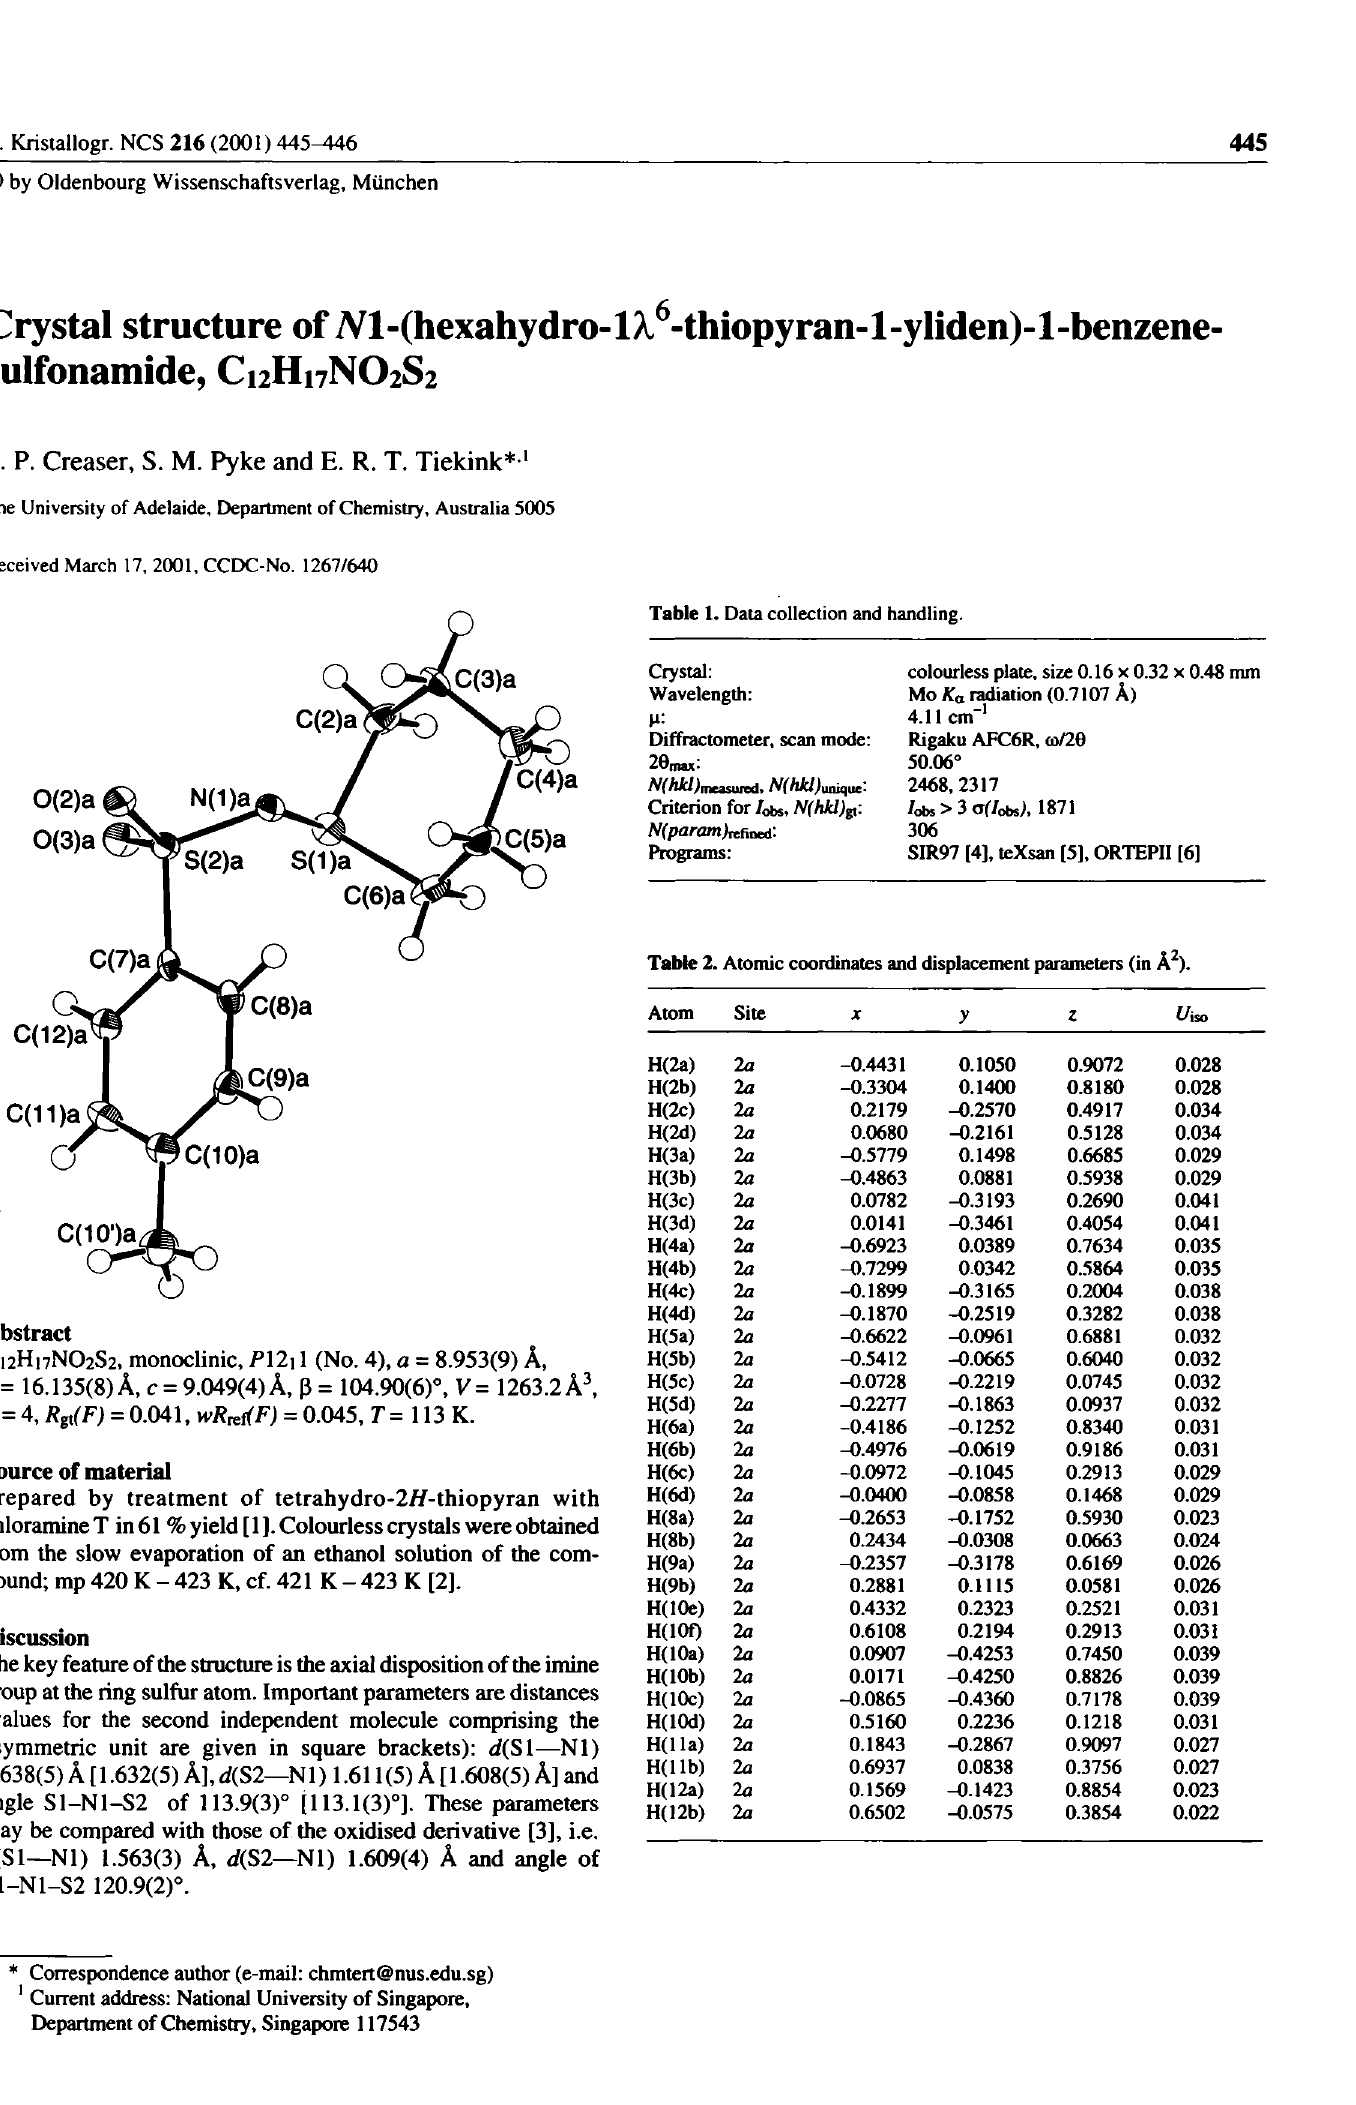
Table 1. Data collection and handling. Crystal: